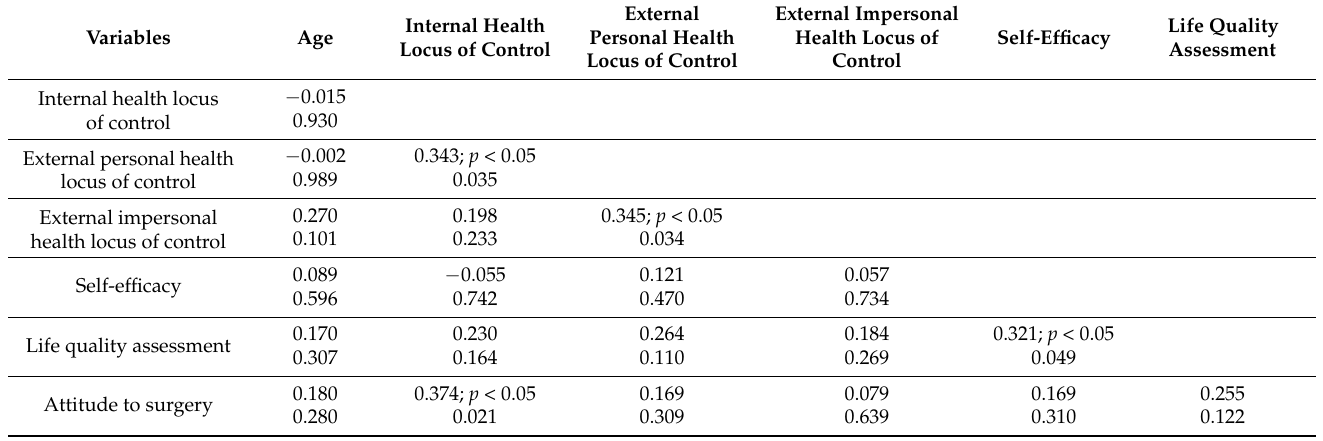
Table 3. Correlations between attitude to surgery, age, and the selected constituents of personal resources in ICAS male